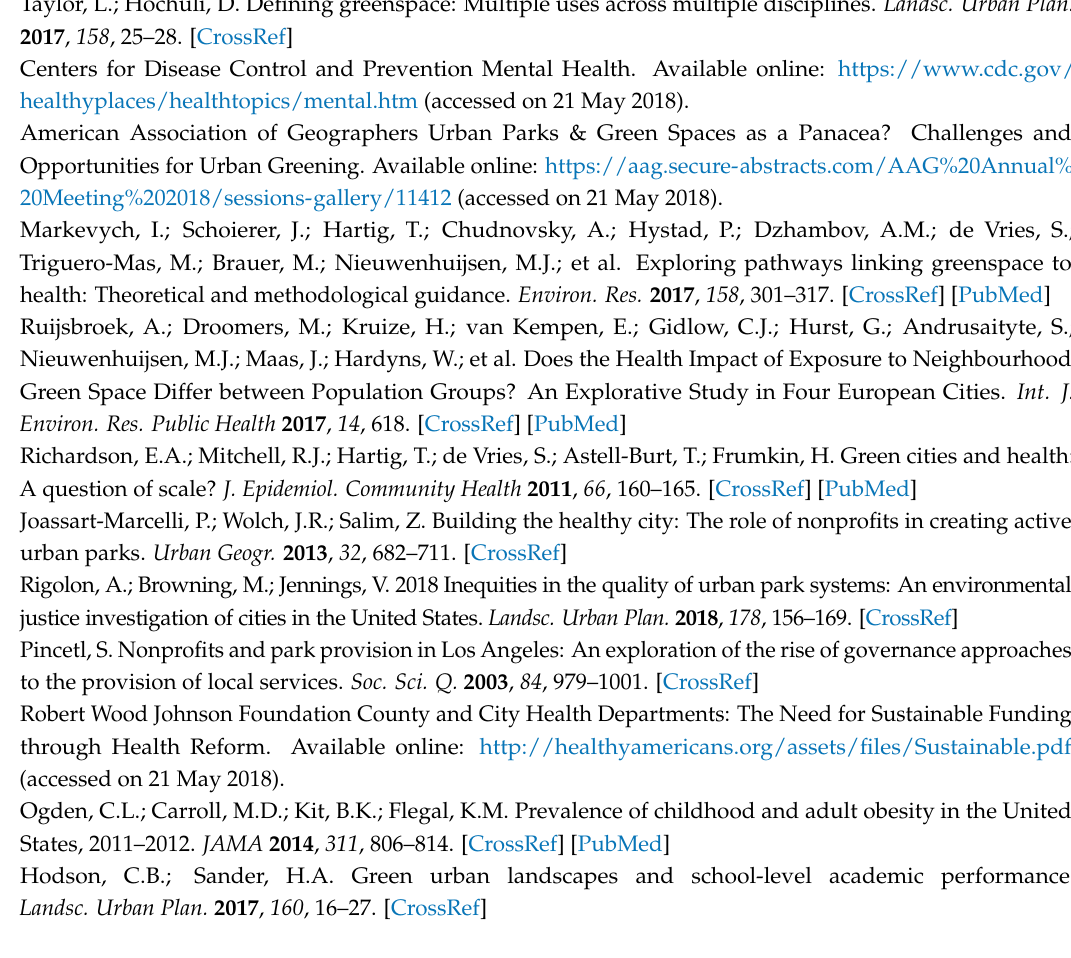
Figure A1. Visual inspection of the Mahalanobis Distance boxplot showed that New York, NY, USA, and Union City, NJ, USA, were hugely different than the other cities in our sample. Mahalanobis Distances were calculated with the following variables: obesity, poor mental health, greenness, tree cover, median income, percent White, percent drivers, population density, median age, percent female, physically inactive, median age of housing, and population .